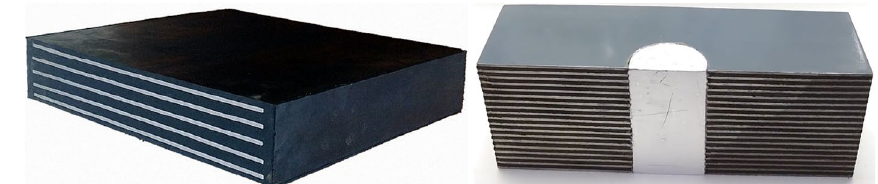
Fig. 2 Elastomeric bearing on the left and lead rubber bearing on the right (source: